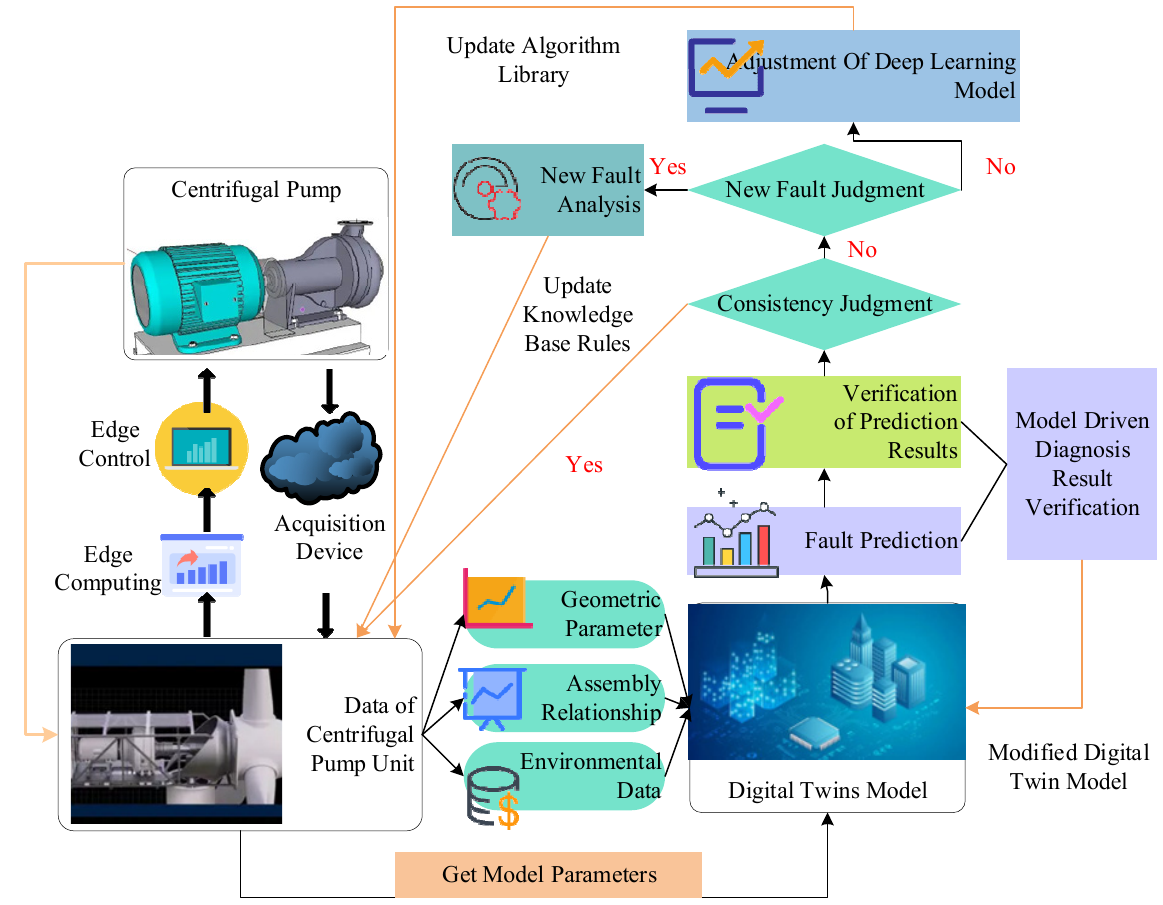
Figure 5. Example of DTT ‐ based IFD’s technical scheme.